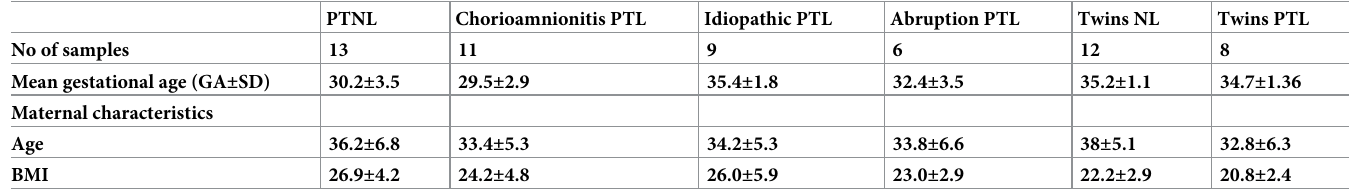
Table 2. Demographic data for preterm myometrial tissue samples